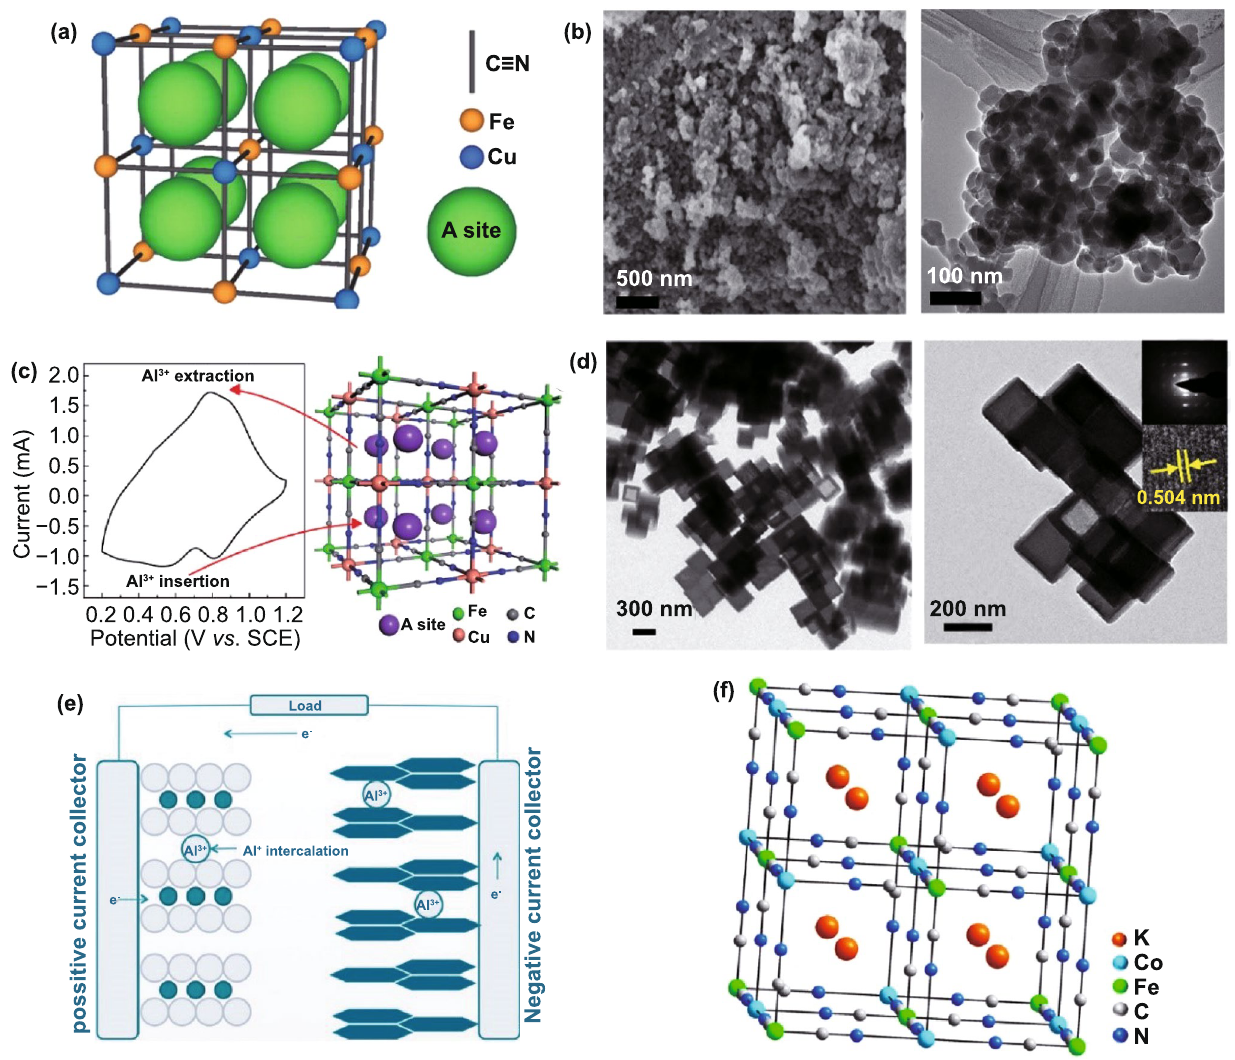
Fig. 11 a Structure of K 0.03 Cu[Fe(CN) 6 ] 0.65 ·2.6H 2 O and corresponding insertion sites for trivalent ions. Reproduced with permission from Ref. [76]. Copyright 2015, Wiley–VCH. b SEM and TEM images of as-prepared KCu[Fe(CN) 6 ]·8H 2 O powders. c Typical CV curve of KCu[Fe(CN) 6 ]·8H 2 O in Al 2 (SO 4 ) 3 solution and the schematic positions of Al 3+ in the framework. Reproduced with permission from Ref. [10]. Copyright 2015, The Royal Society of Chemistry. d TEM image of K 2 CoFe(CN) 6 . Reproduced with permission from Ref. [135]. Copyright 2020, Elsevier. e Working process of aqueous CuFe(CN) 6 /TiO 2 battery for Al 3+ storage. Reproduced with permission from Ref. [134]. Copyright 2018, Springer. f Crystal structure of K 2 CoFe(CN) 6 . Reproduced with permission from Ref. [135]. Copyright 2020,